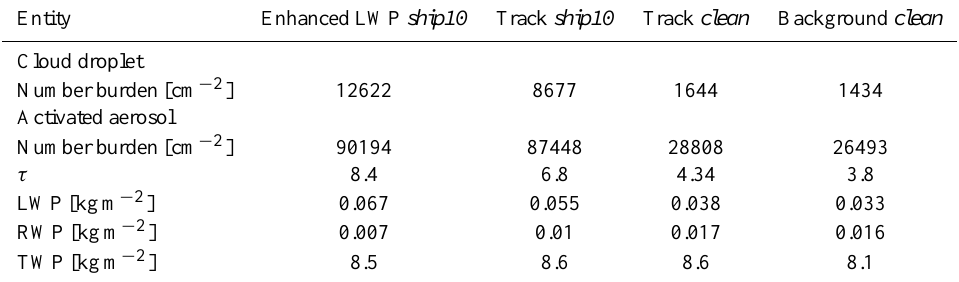
Table 3. Overview of changes in microphysical (cloud droplet and activated aerosol number burdens), radiative ( τ ) and macrophysical entities (LWP, total water path (TWP) and rain water path (RWP)) averaged over the following and regions and simulations: the